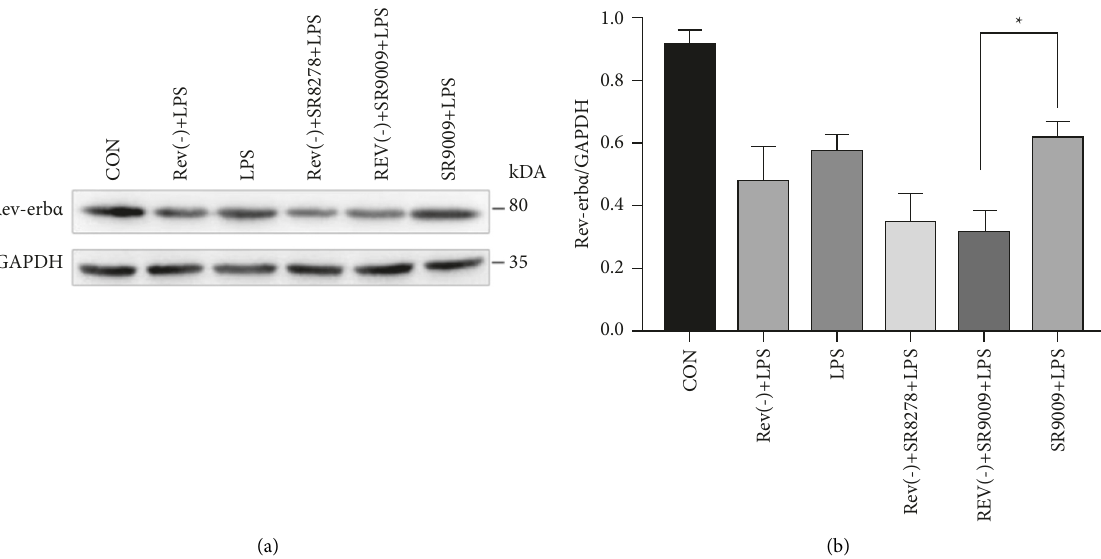
Figure 2: (a) Western blot analysis of Rev-Erb α in normal and Rev-Erb α knock-down RAW246.7 cells treated with DMSO, LPS, SR9009, SR9009+LPS, and SR8278+LPS and (b) Rev-Erb α /GAPDH ratio in RAW246.7 cells after LPS induction and SR9009 and SR8278 treatment. Significant differences: ∗ p < 0 . 05.